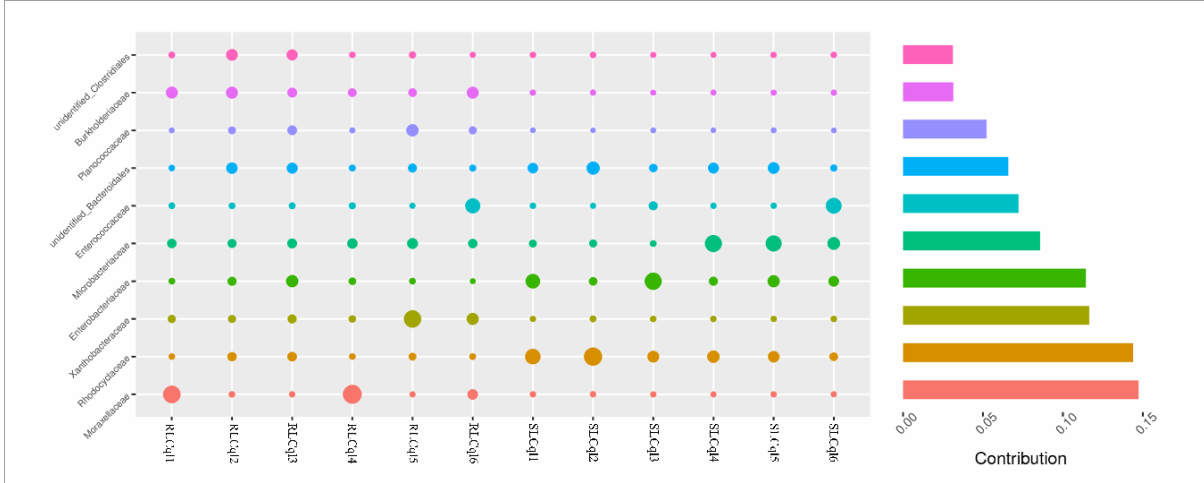
FIGURE5 Genus-level contributions in strains of Culex quinquefasciatus that are susceptible and resistant to Lysinibacillus sphaericus C 3